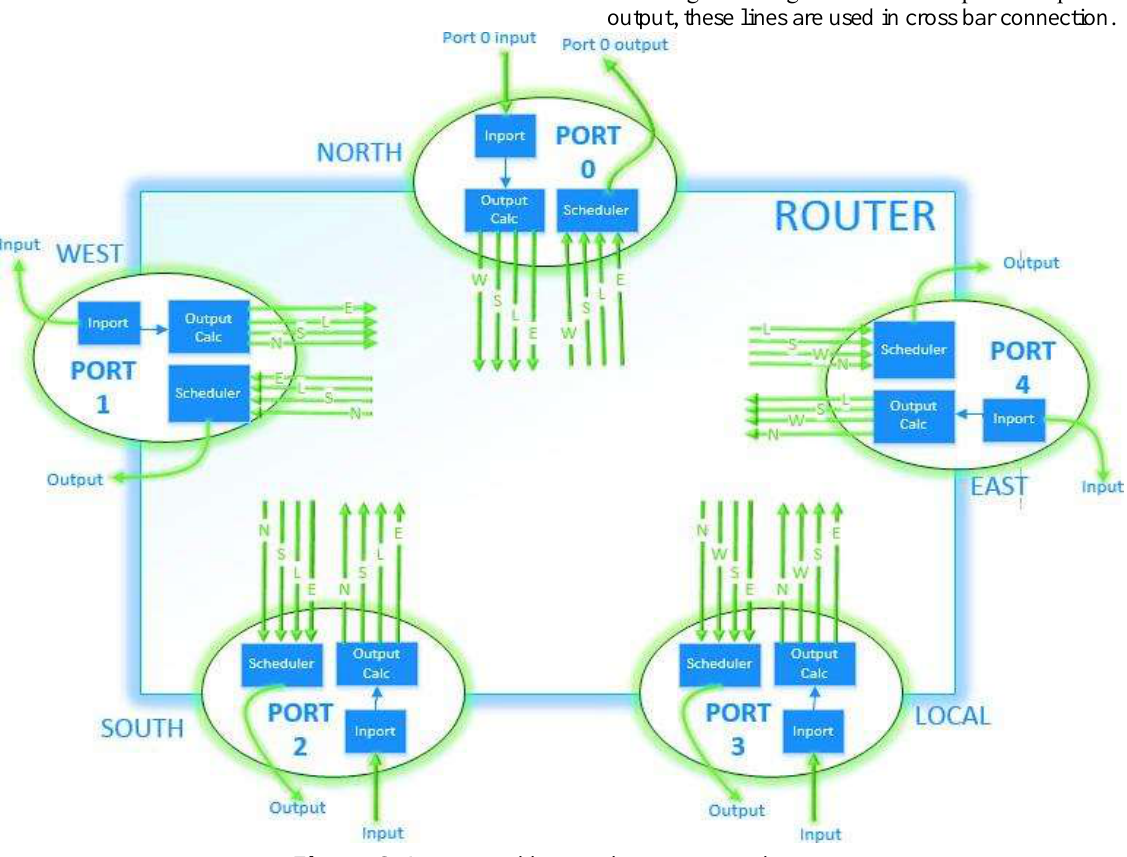
Figure 6. A router with crossbar connected